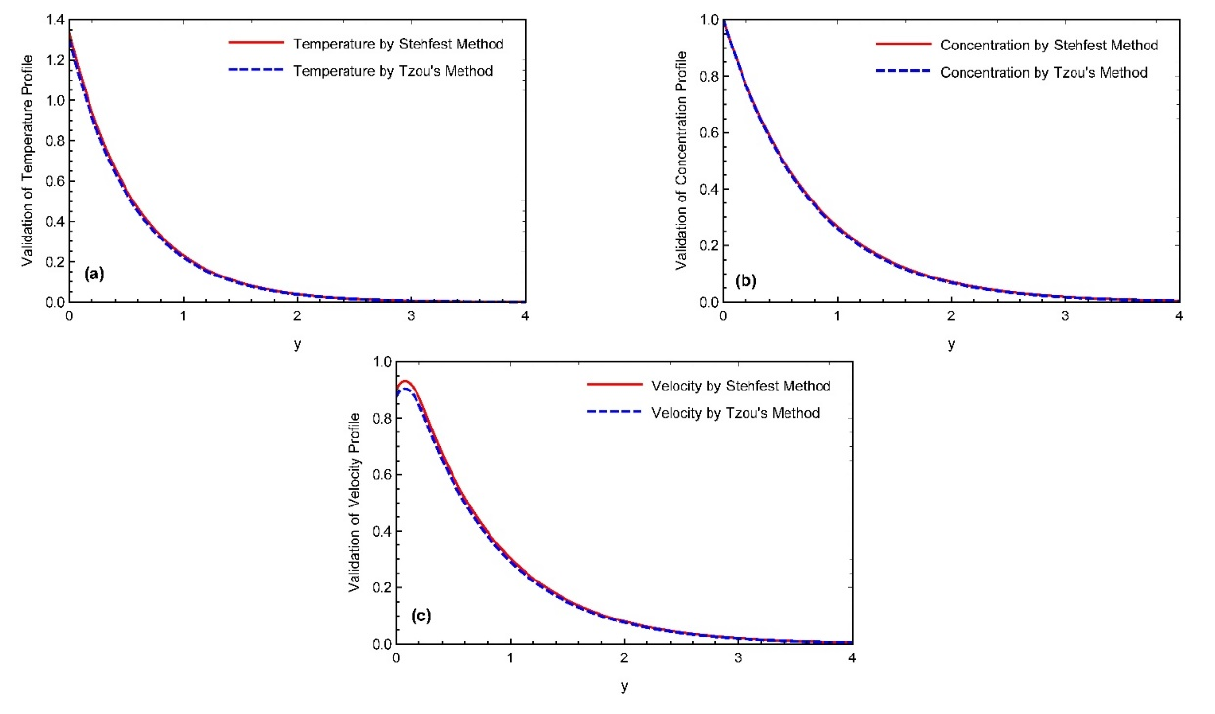
Figure 14. Validation of all governed profiles by different numerical schemes. ( a ) Temperature ( b ) Concentration ( c ) Velocity.